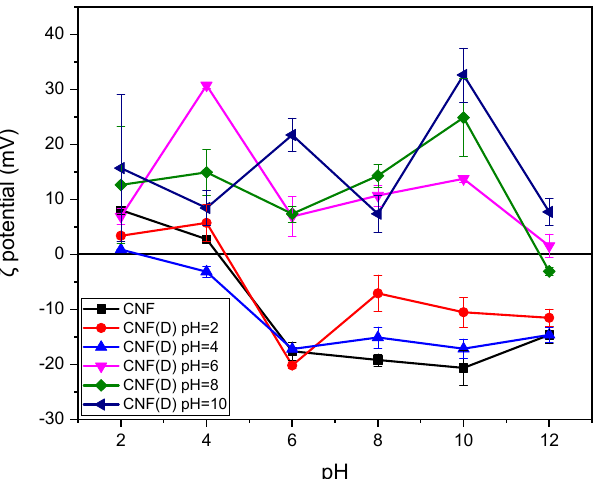
Figure 4. ζ potential values (mV) for CNF and CNF(D) at different pH reaction conditions (2, 4, 6, 8, and 10).